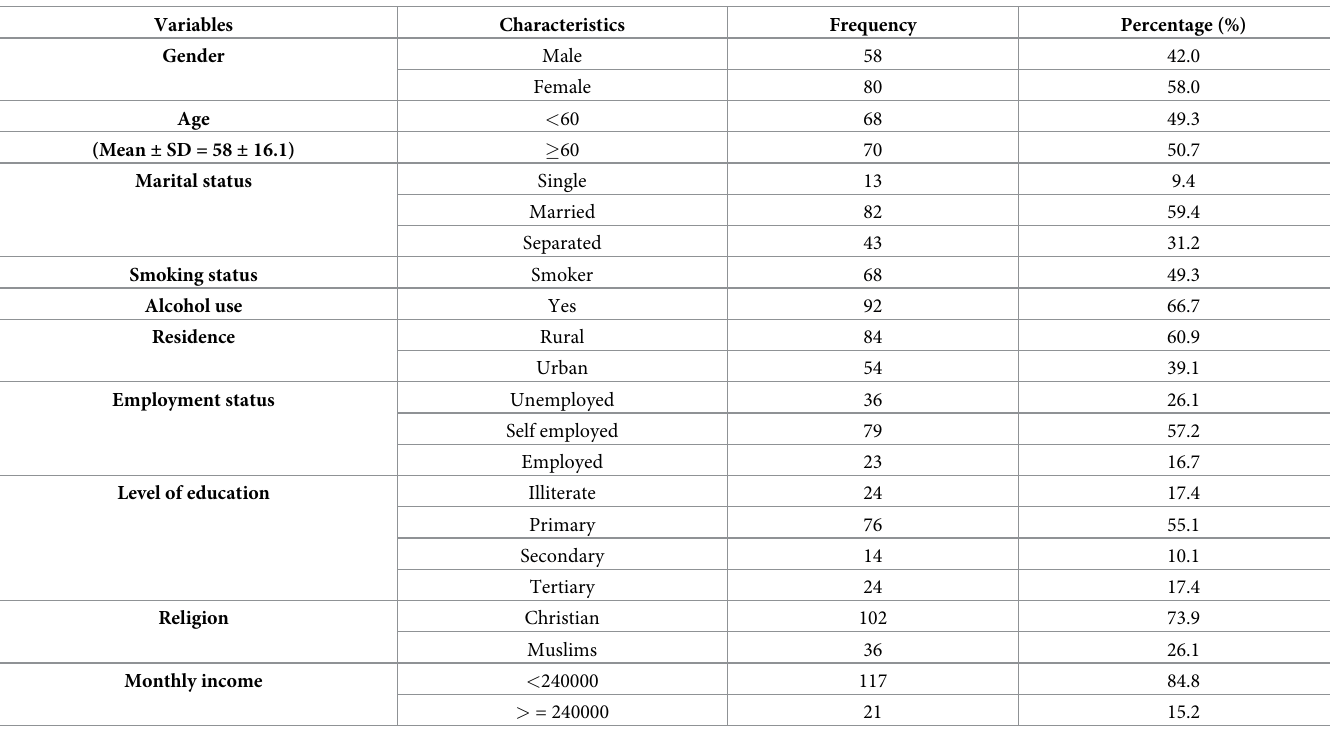
Table 1. Sociodemographic characteristics of T2DM patients at medical and surgical wards of MRRH from November 2021 to January 2022, Mbarara,